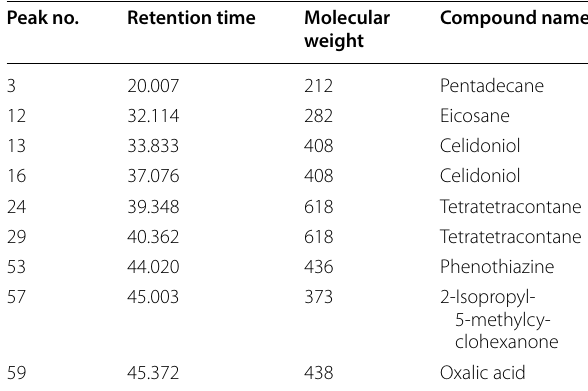
Table 4 Details of peaks identified during GC–MS analysis of acetaminophen degradation by Bacillus drentensis strain S1 Peak